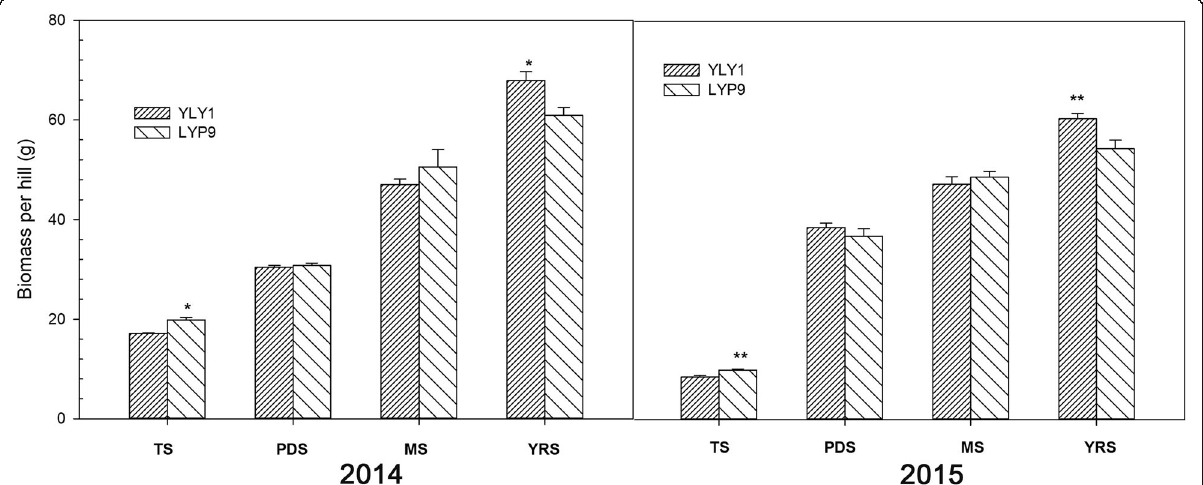
Fig. 5 The above ground biomass dry weights for both YLY1 and LYP9 at different developmental stages during the growth seasons in 2014 and 2015. See definitions of different stages in Fig. 4. “ *, ” “ ** ” represent significance levels of p = 0.05 and p = 0.01 levels, respectively. The bar represents the standard deviation of 10